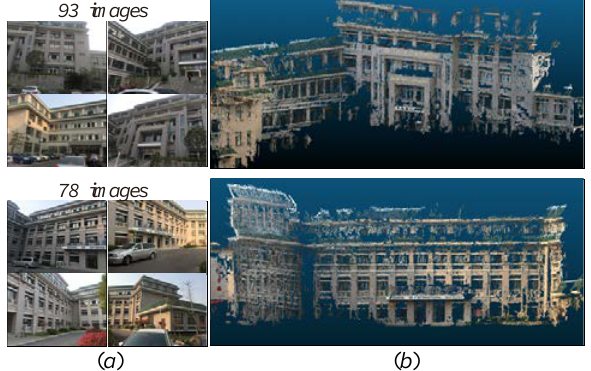
Figure 7. Clustered building images and ground image point clouds for a student dorm (top, 93 images) and an instruction building (bottom, 78 images). (a) clustered building images; (b) ground image point clouds.